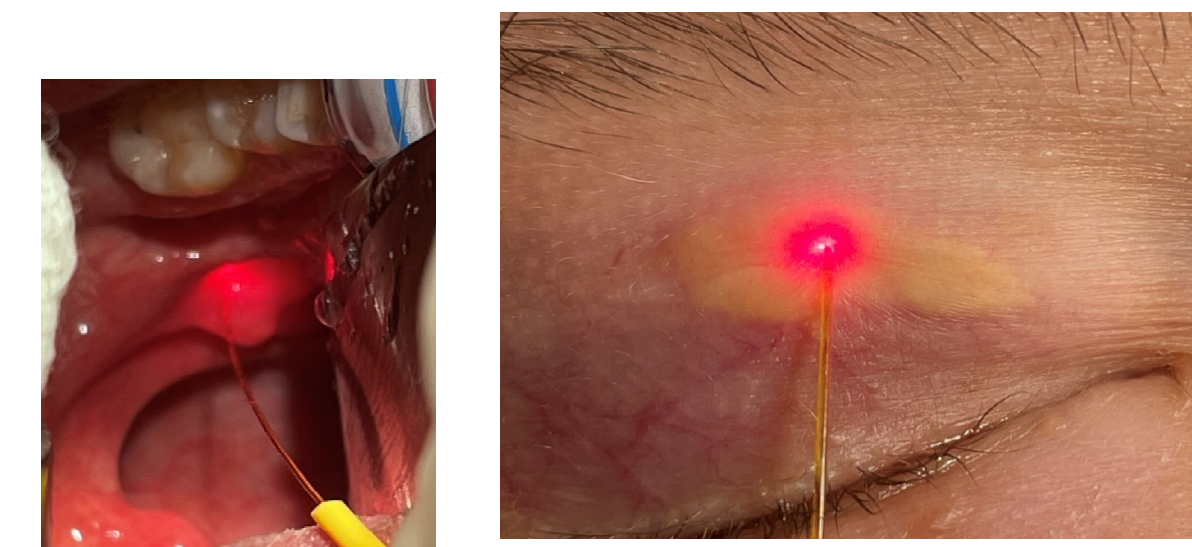
Figure 5. Laser-assisted removal of cancerous tissue.